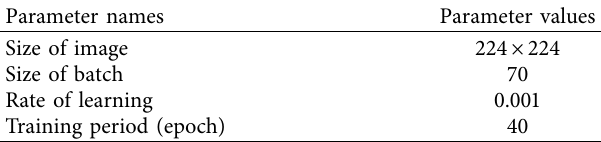
Table 3: Experimental parameter.